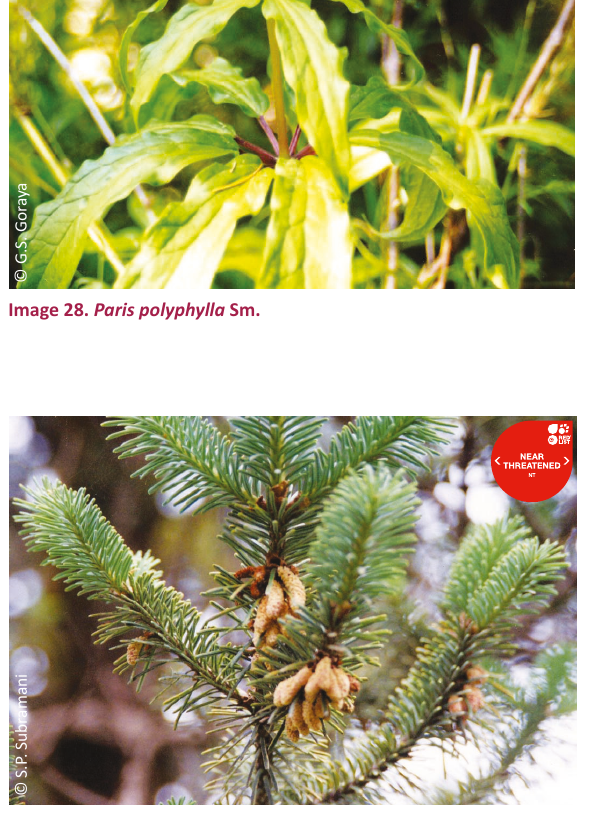
Image 30. Abies spectabilis (D.Don) Mirb.